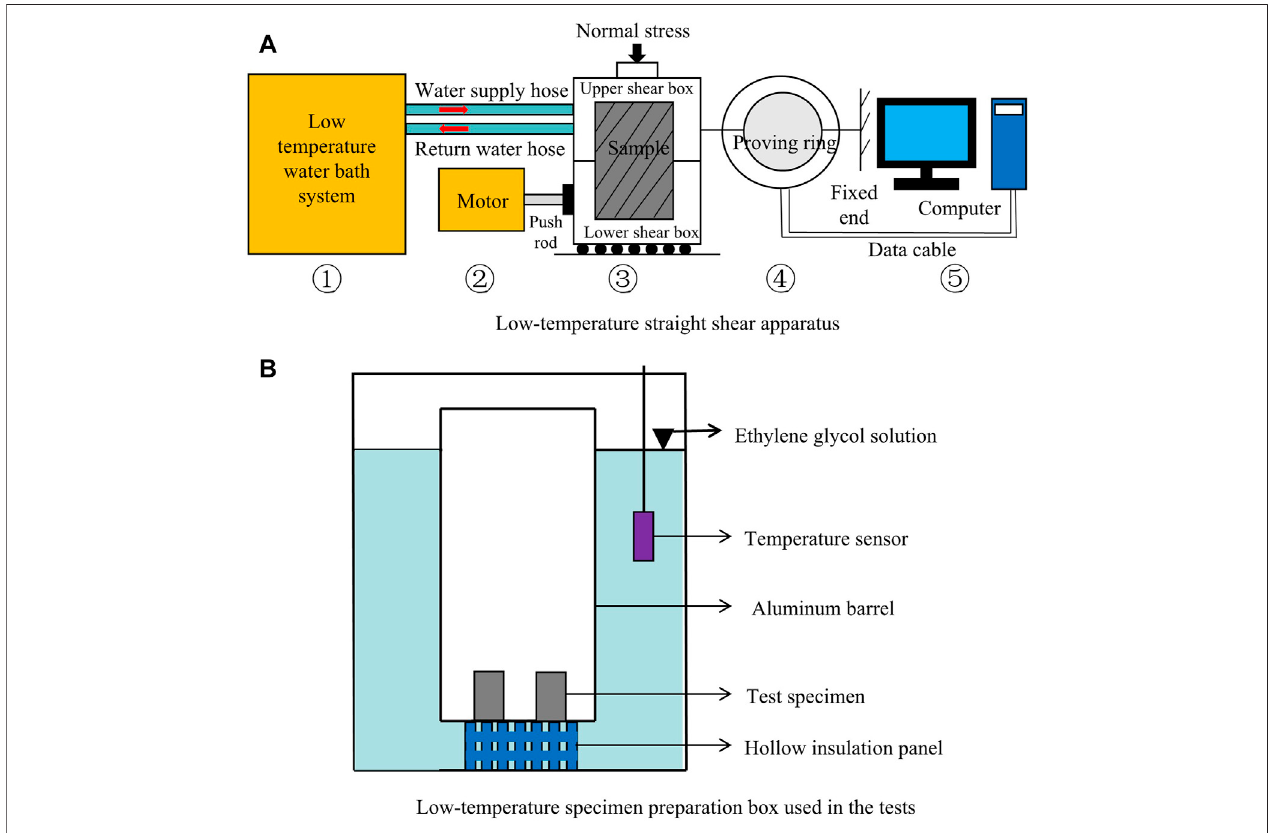
FIGURE 1 | Schematic diagram of (A) the low-temperature straight shear apparatus and (B) the low-temperature specimen preparation box used in the tests.